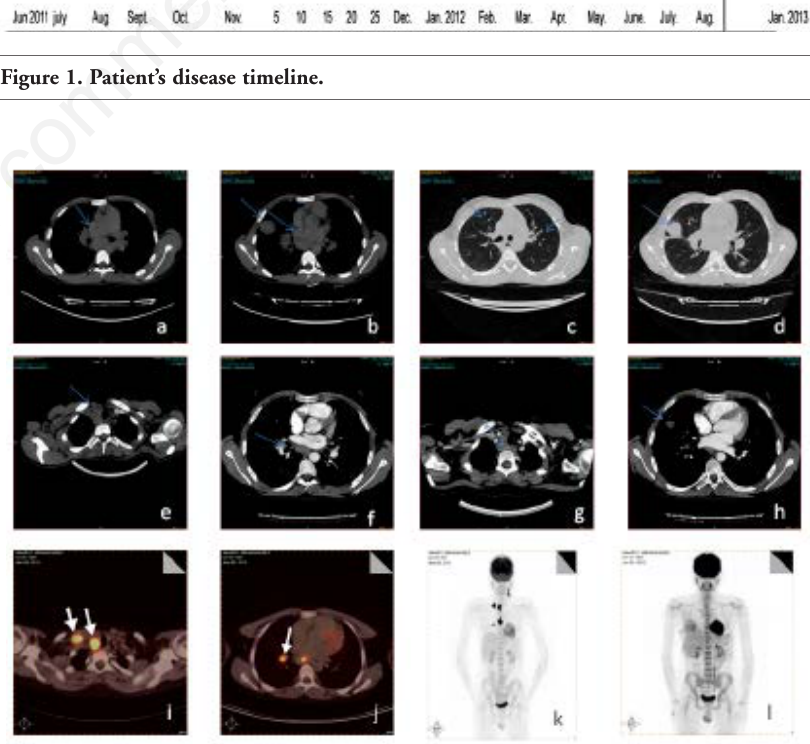
Figure 2. Computed tomography and positron emission tomography-computed tomog- raphy